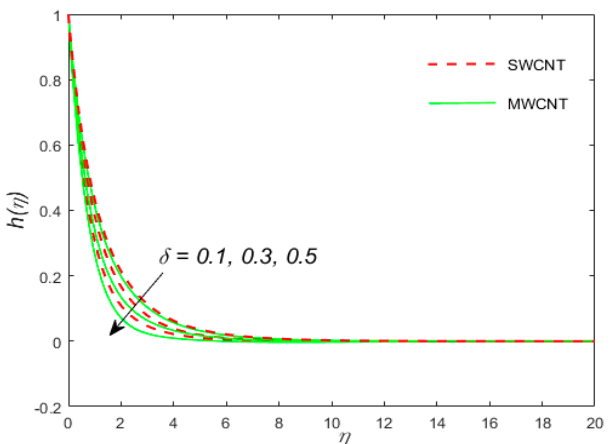
Figure 17. The variation of the local density of motile microorganisms h ( η ) for the case of SWCNT and MWCNT versus the similarity variable for the distinct values of the bio-convection constant δ .